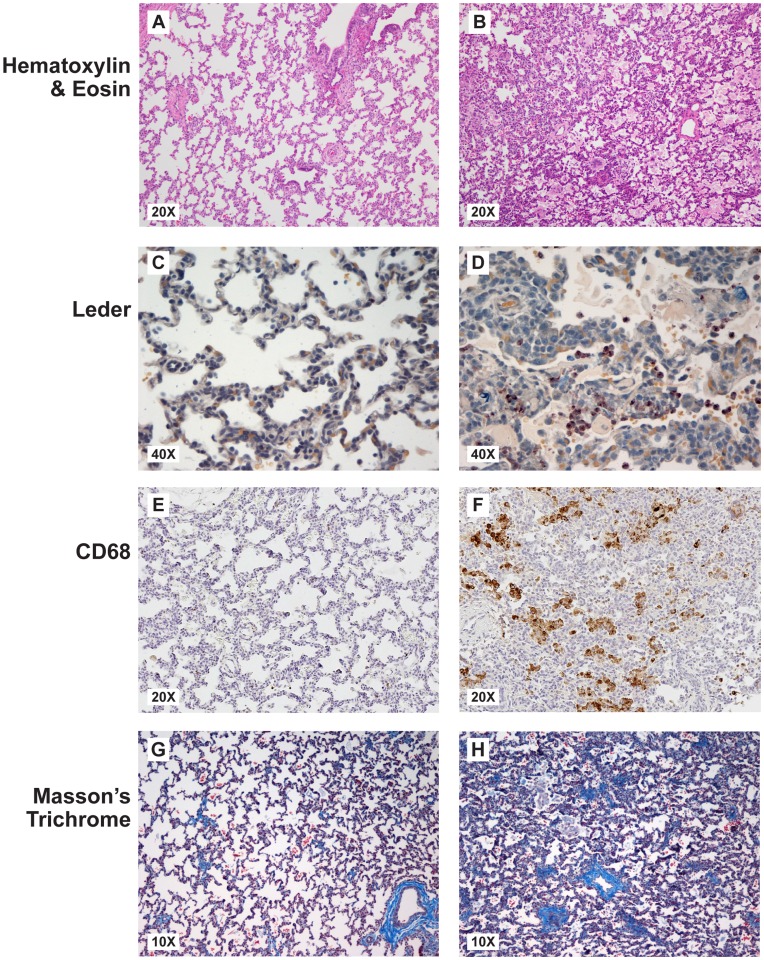
Histopathology of the fetal lungs are shown on the left for a saline control with lung score of 0 (A, C, E, G) and on the right for a GBS animal with severe fetal lung injury and lung score of 4 (B, D, F, H).Panels show hematoxylin and eosin staining (A, B), Leder staining for neutrophils (C, D), CD68 staining for macrophages (E, F), and Masson’s Trichrome staining for collagen (G, H).